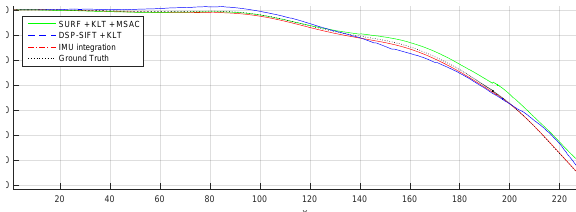
Figure 8: The comparison between proposed method, IMU inte- gration and MSCKF on case